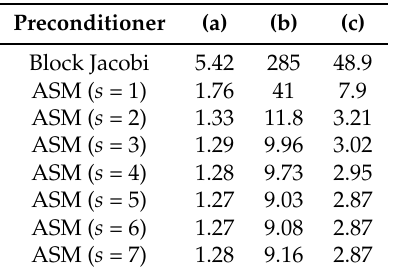
Table 2. Simulation times ( s ) for shell Partitioner.